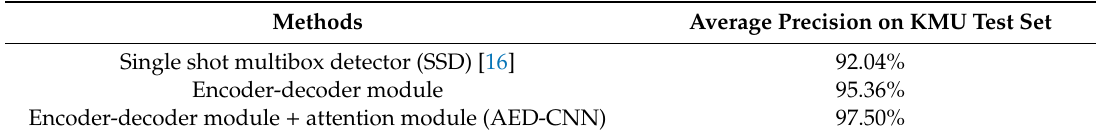
Table 2. Results of the ablation experiments on KMU test